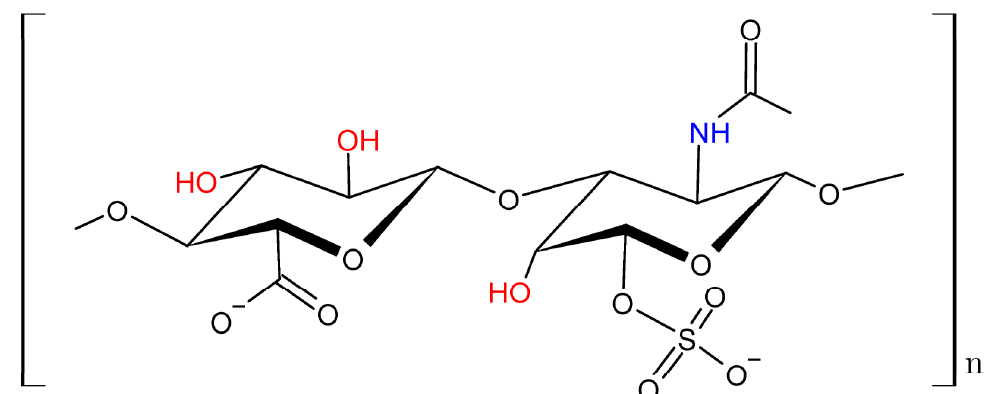
Figure A7. The molecular formula of chondroitin sulfate, the most abundant glycosaminoglycan in cartilage. The three exchanging hydroxyl groups (-OH) are highlighted in red, and the one exchanging amide group (-NH) in